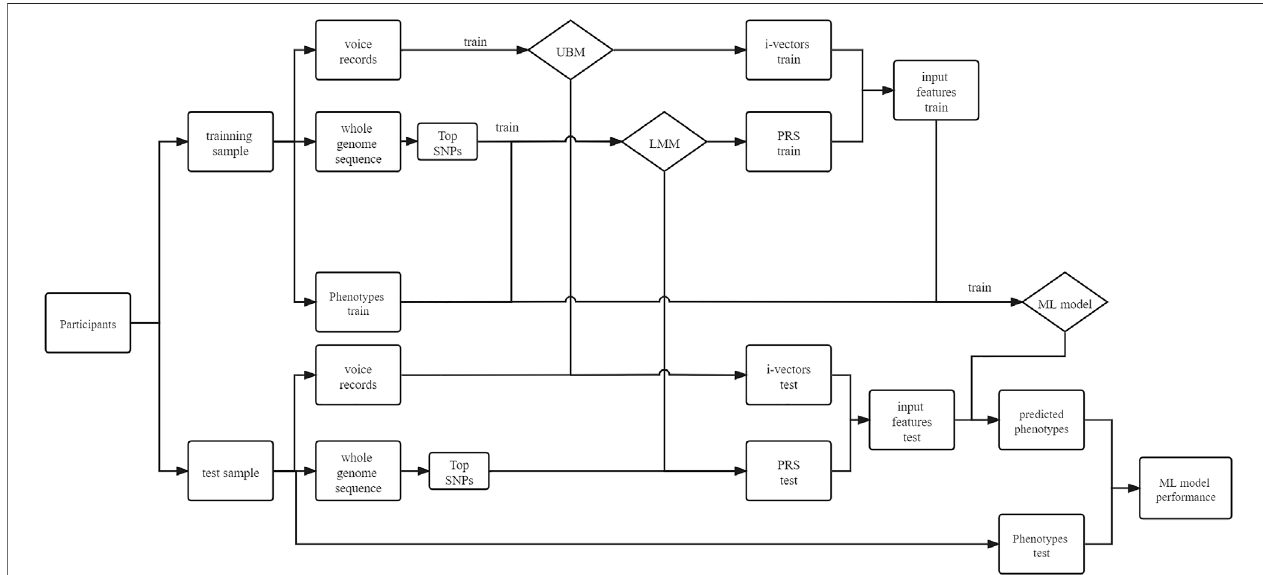
FIGURE 1 | Fivefold cross-validation of voice – gene data. In each fold, the samples were split into a training group and a test group. Voice and genetic sequence data of the training group were used to train the universal background model (UBM) and linear mixed model (LMM) separately. Then, i-vectors for the training and test groups were extracted through the UBM, and the polygenic risk score (PRS) can be calculated through the LMM. The i-vectors and PRS will be concatenated as input features for a machine learning (ML) model.